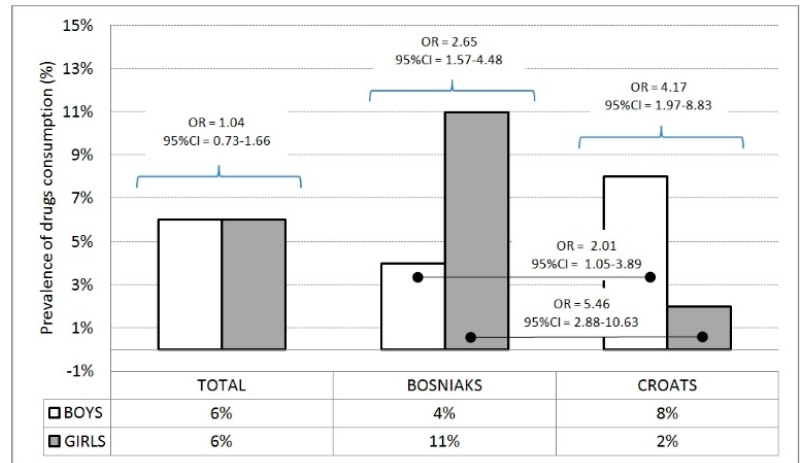
Figure 3. Prevalence of consumption of other drugs with odds ratio between and within genders. Percentage of reported frequency for boys (the 100% being 214 and 485 for Croats and Bosniaks, respectively) and girls (the 100% being 558 and 485 for Croats and Bosniaks, respectively).